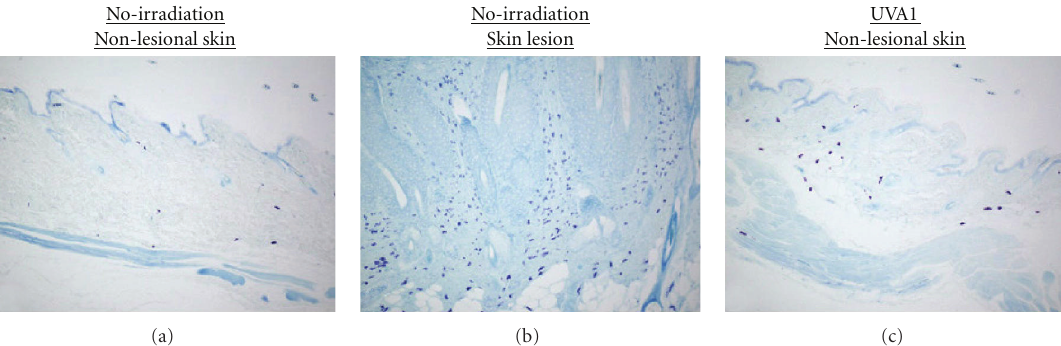
Figure 3: Dermal infiltration of mast cells in the lesional and nonlesional skin representative MRL/lpr mice. (a): nonlesional skin of non- irradiated mice. (b): spontaneous LE-like skin lesion of nonirradiated mice. (c): nonlesional skin of UVA1-irradiated (10J/cm 2 ) mice. In the LE-like skin lesions, the most remarkable infiltration of mast cells into dermis was detected (b). There was more number of mast cells infiltrating into the dermis of the UVA1-irradiated (10J/cm 2 ) mice (c), as compared to the nonirradiated mice (a). Toluidine blue stain, original magnification, × 100.